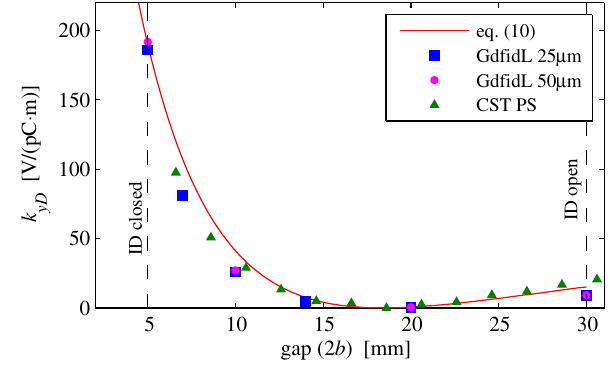
FIG. 8. Dipole vertical kick factor — gap dependence.